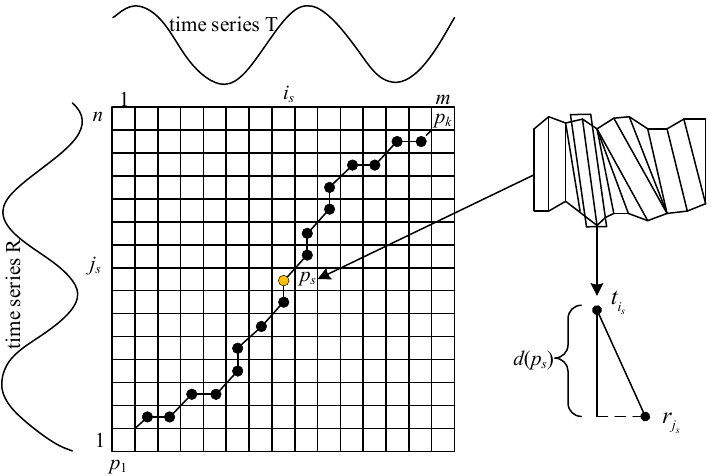
Figure 3. Schematic diagram of DTW path.